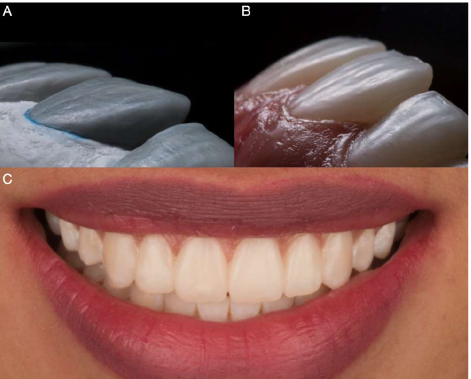
Figure 2. Diagnostic mock-up. ( A ) Diagnostic wax-up. ( B ) Intraoral close-up of diagnostic mock-up. ( C ) Extraoral view of diagnostic mock-up while smiling. The putty reduction guide (Hydrorise putty, Zhermack, Badia Polesine, Italy) was made based on the diagnostic wax-up for both central incisors. Ultraconservative tooth preparations were provided with the diagnostic mock-up on, starting with horizontal re- duction grooves. The reduction guide was intermittently placed to evaluate the amount of tooth removal. Cord 0 (Ultrapak, Ultradent Products Inc, South Jordan, UT, USA) was packed prior to finalizing the cervical third of the preparation, and the final tooth prepa- rations were polished using discs (Sof-Lex Discs, 3M Oral Care, St Paul MN, USA) (Figure 3). Figure 3. Ultraconservative tooth preparations. ( A ) Lateral view of horizontal reduction grooves. ( B ) Tooth preparations in process. ( C ) Incisal view of preparation evaluated with a reduction guide. ( D ) Finalized tooth preparations (gingival retraction cords in both centrals). The final impression of the tooth abutments used light- and heavy-body consistency PVS materials (Virtual 380, Ivoclar Vivadent, Schaan, Liechtenstein) (Figure 4).